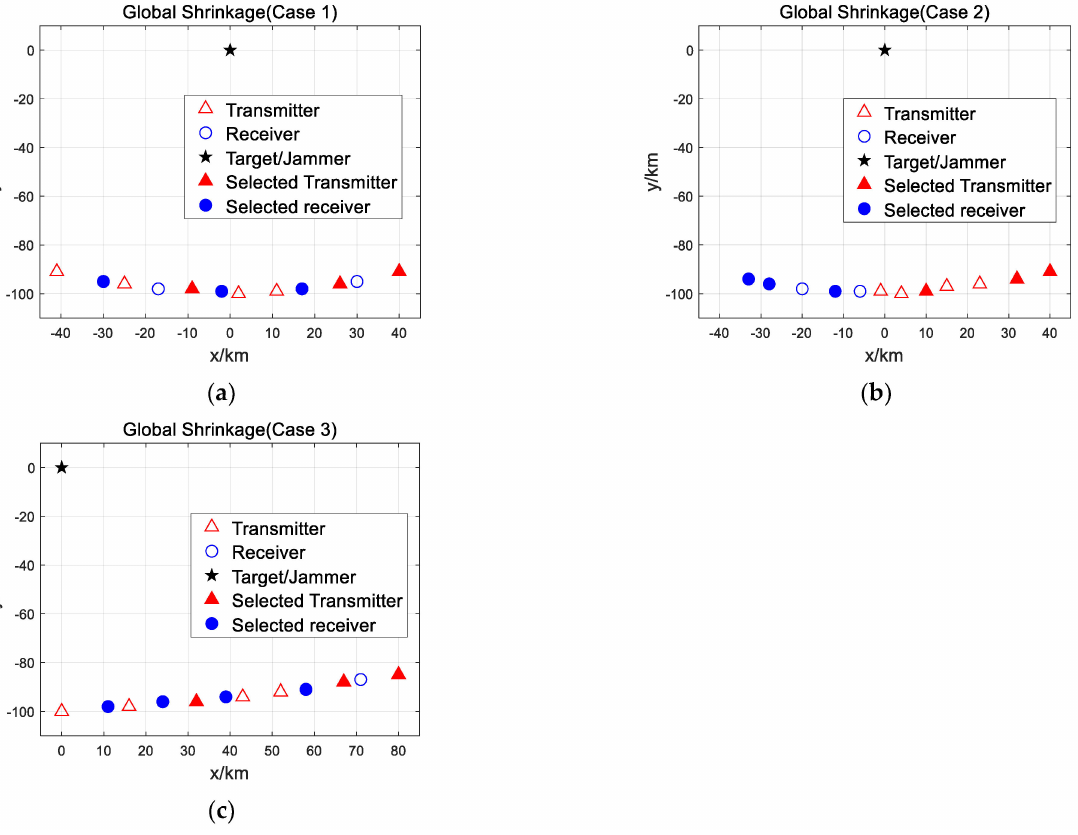
Figure 5. The influence of SNR variation in each channel: ( a ) Case 1, ( b ) Case 2, ( c ) Case